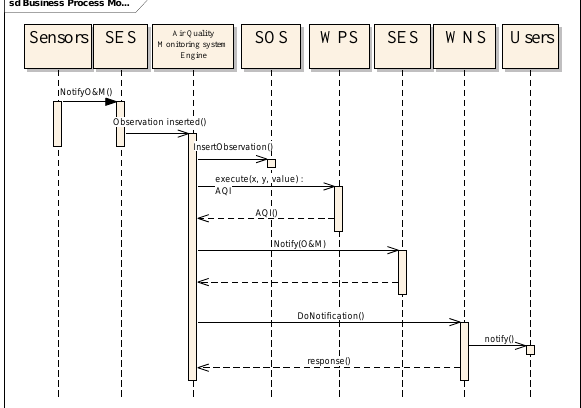
Figure 2. Air pollution monitoring system Sequence